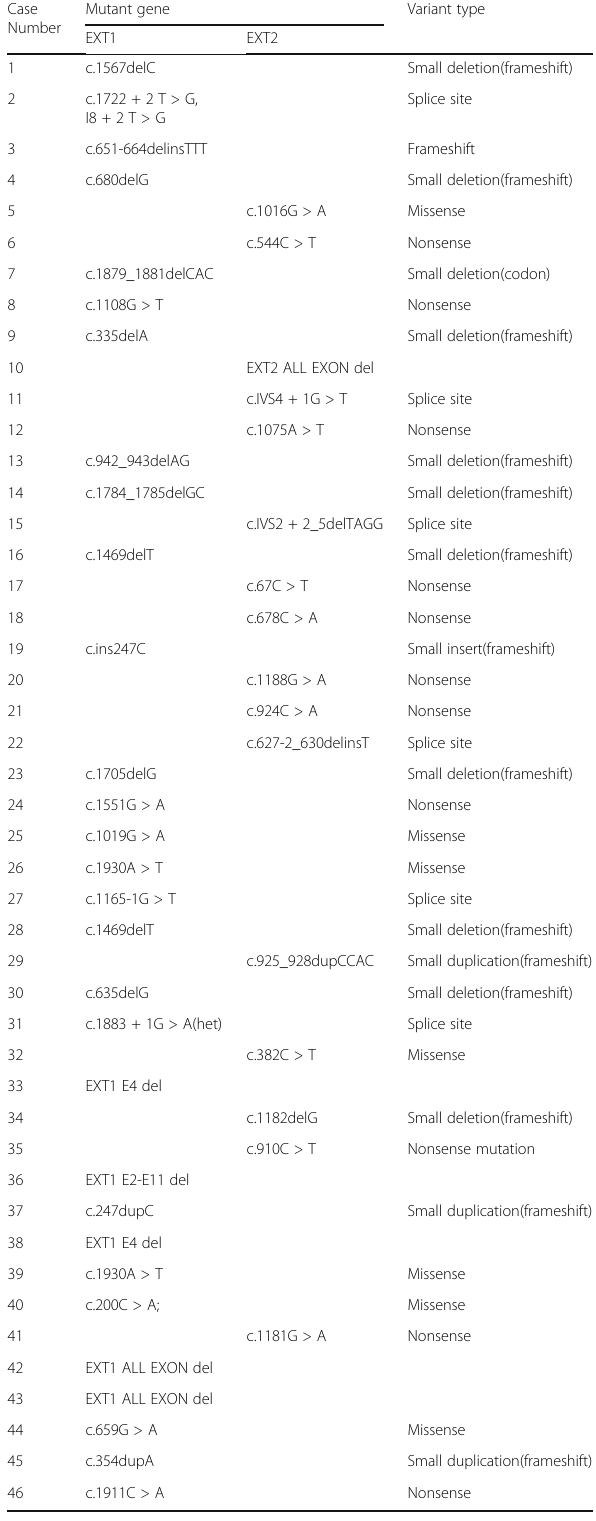
Table 2 EXT1 and EXT2 mutations in patients Case Mutant gene Number